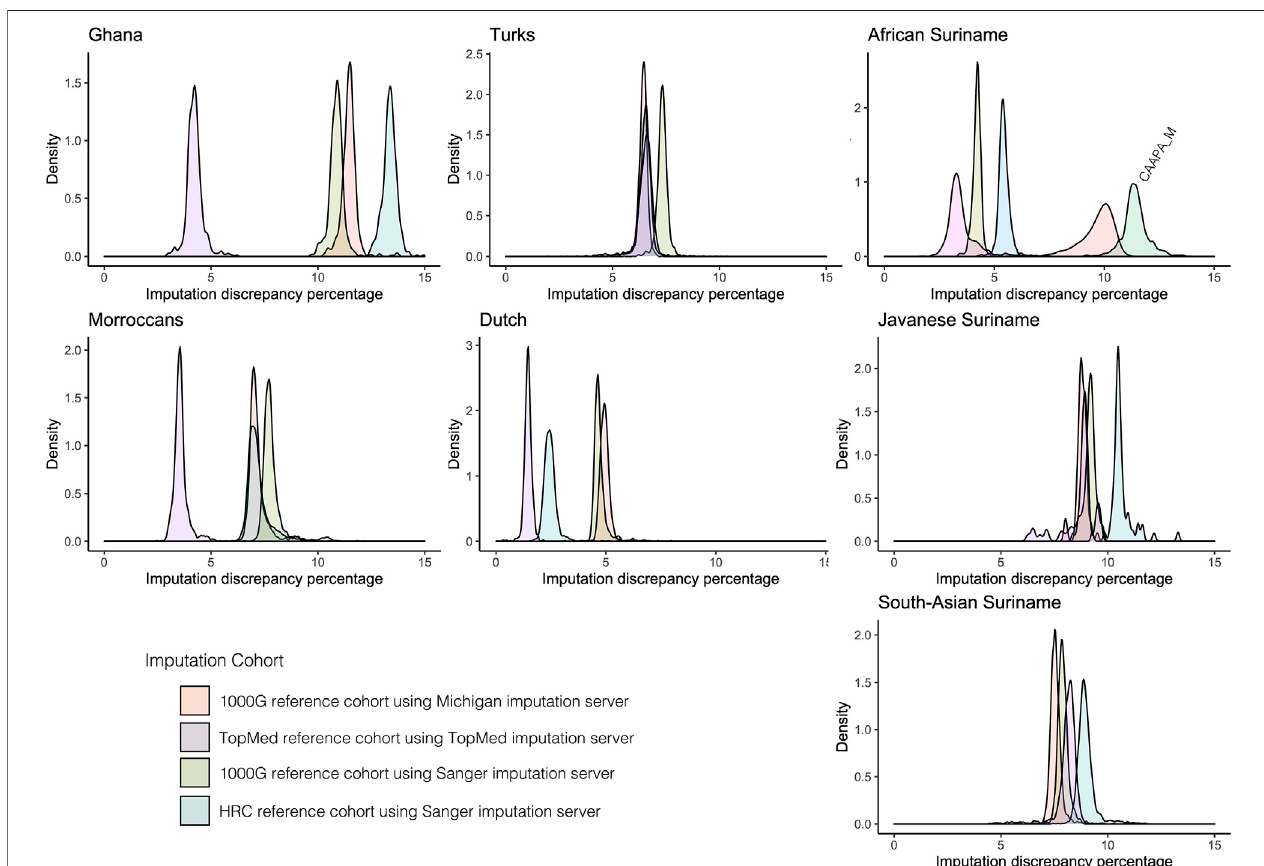
FIGURE 2 | Comparison of imputation reference panels on HELIUS. Imputation performance was determined by fi ltering out 25% of the measured markers per ethnicity.After fi lteringout,themarkersimputationwasperformedwiththeSangerserverusingthe1000GandHRCimputationreferencepanels,Michiganimputationserver with the 1000G, and TopMed imputation reference panel.The Michigan imputation cohort CAAPA was also used for imputationon the AfricanSurinamese. Plots showthe density of the percentage mismatches between imputed and measured genotypes per individual for each imputation server and reference panel per ethnicity.